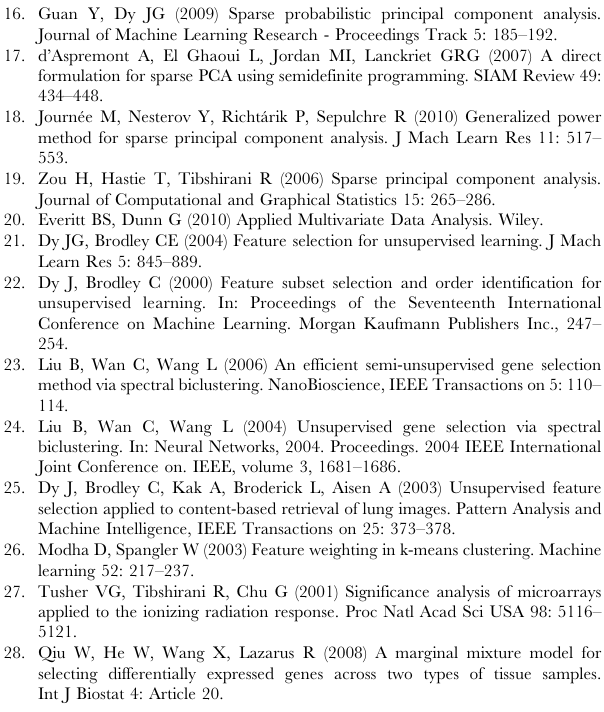
Figure S3 Performances of discrimination between diseases using the optimal number of PCs. Accuracy, sensitivity, specificity, and precision of each discrimination between diseases using the optimal number of PCs. The 15 columns correspond to, from left to right, lung cancer, control, multiple sclerosis, other pancreatic tumors and diseases, pancre- atitis, ductal pancreatic cancer, gastric cancer, sarcoidosis, melanoma, Wilm’s tumor, prostate cancer, acute myocardial infarction, periodontitis, ovarian cancer, and COPD. Actual values can also be found in Table S3. Table S1 Frequency of miRNAs selected by several feature selections. Frequency of miRNA selection within 90% sampling by feature selection based on PCA (100), t -test (100), RFE ensemble (100), and UFF (100). Numbers in parentheses are the numbers of subsamplings. Cells filled with ‘‘100’’ indicate that the miRNA was always selected by feature extraction for discrimination between patients with the disease denoted at the top of column and healthy controls. Table S2 Frequency of miRNAs selected for discrimi- nation between diseases. The pair discriminated is the intersection of the table and column names, e.g., if an miRNA was selected by feature extraction for discrimination between lung cancer and control, 1 was substituted in the cell located in the row named for the miRNA and in the column named as the control in the table named as ‘‘lung cancer’’. Table S3 Performance of discrimination between dis- eases using the optimal number of PCs. Accuracy, specificity, sensitivity, and precision of discrimination between diseases using the optimal number of PCs. The pair discriminated